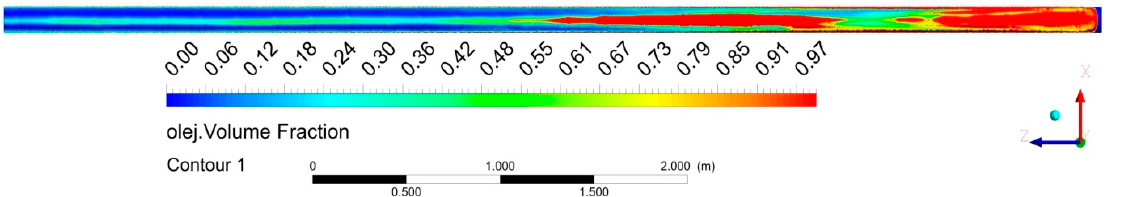
Figure 3. Volume of the oil at the surface of the pipe over its full length at the speed of 4 m/s with a pipe diameter of 35 mm.